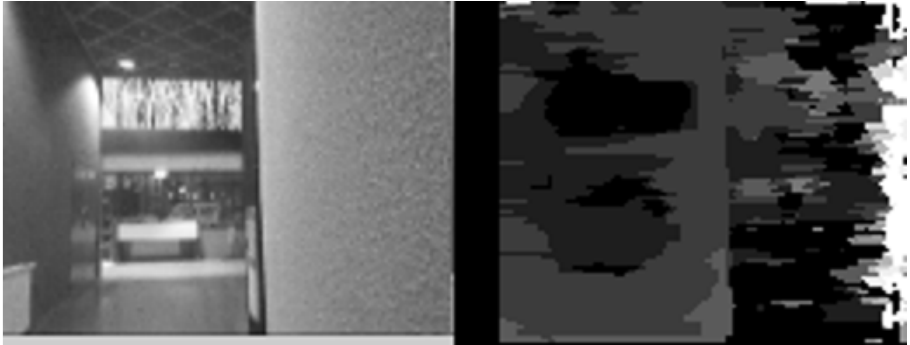
Figure 4. Result of the implemented stereo vision method (based on [29]) on images of a corridor with a curved wall with little texture on the right side. The disparity map gives a poor result on the right side.